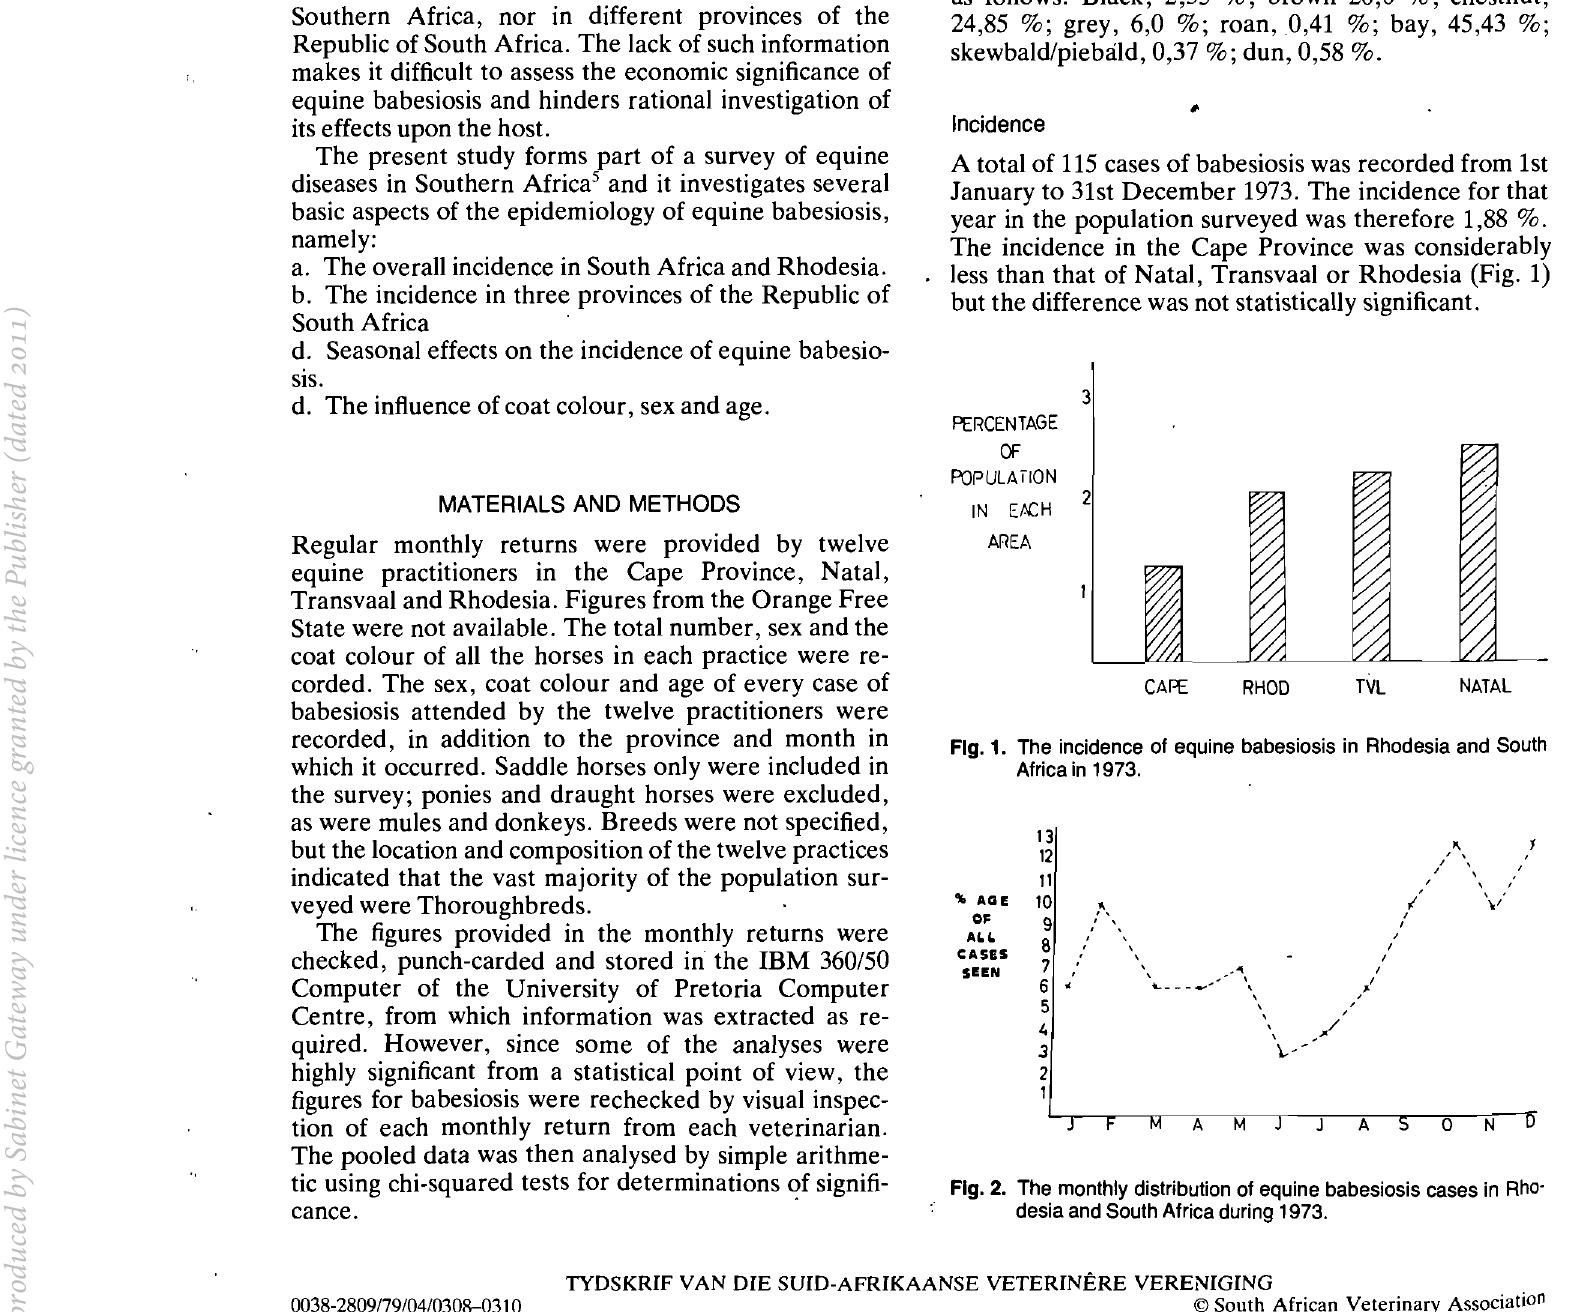
TYDSKRIF VAN DIE SUID-AFRIKAANSE VETERINERE VERENIGING 0038-2809179/04/0308-0310 © South African Veterinary